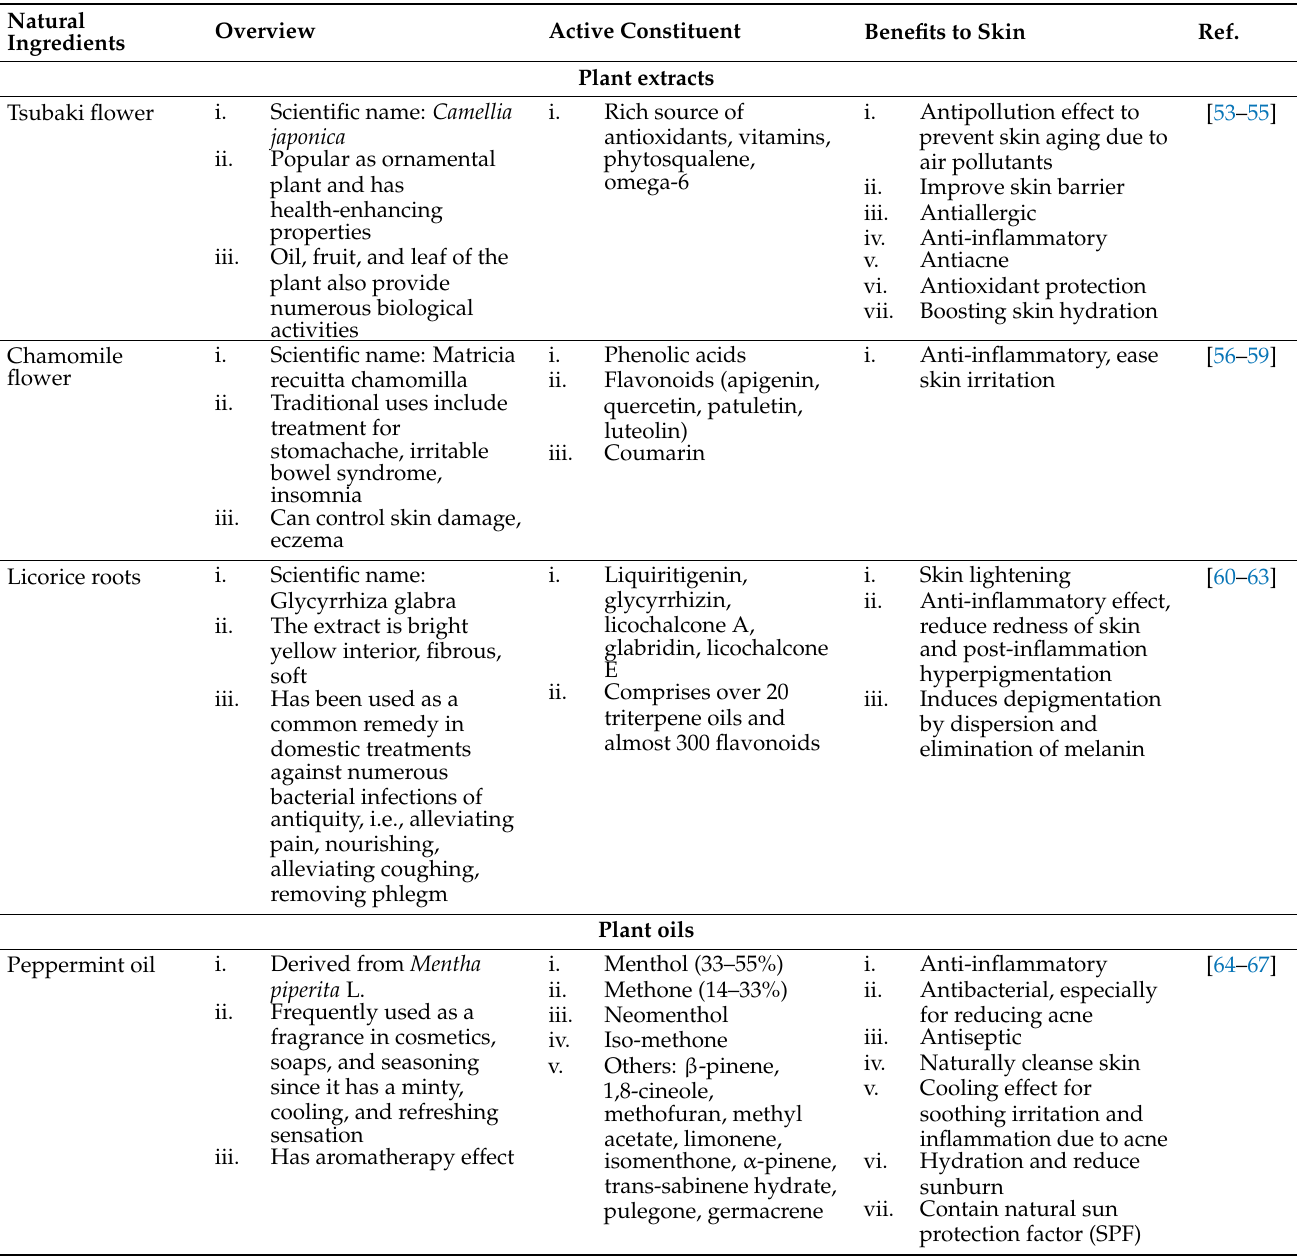
Table 1. Natural ingredient examples commonly used in